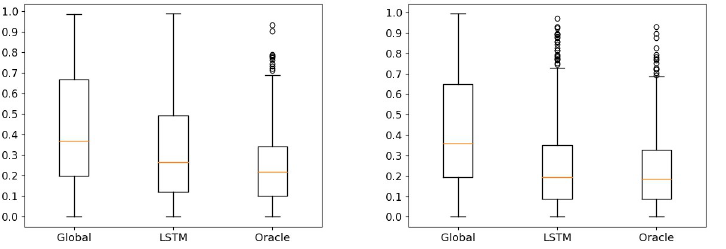
Fig 11. Boxplots of the distance between the experienced tracks and the experience-based tracks. The left one shows the testing data-set and the right one the training data-set.